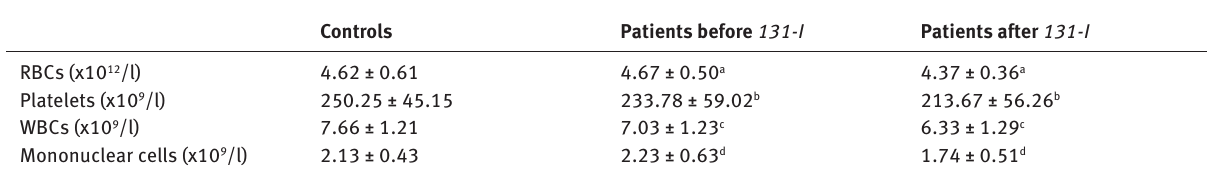
Table 2: Mean values for peripheral blood cell counts in control subjects and DTC patients before and 7 days after radioiodine therapy